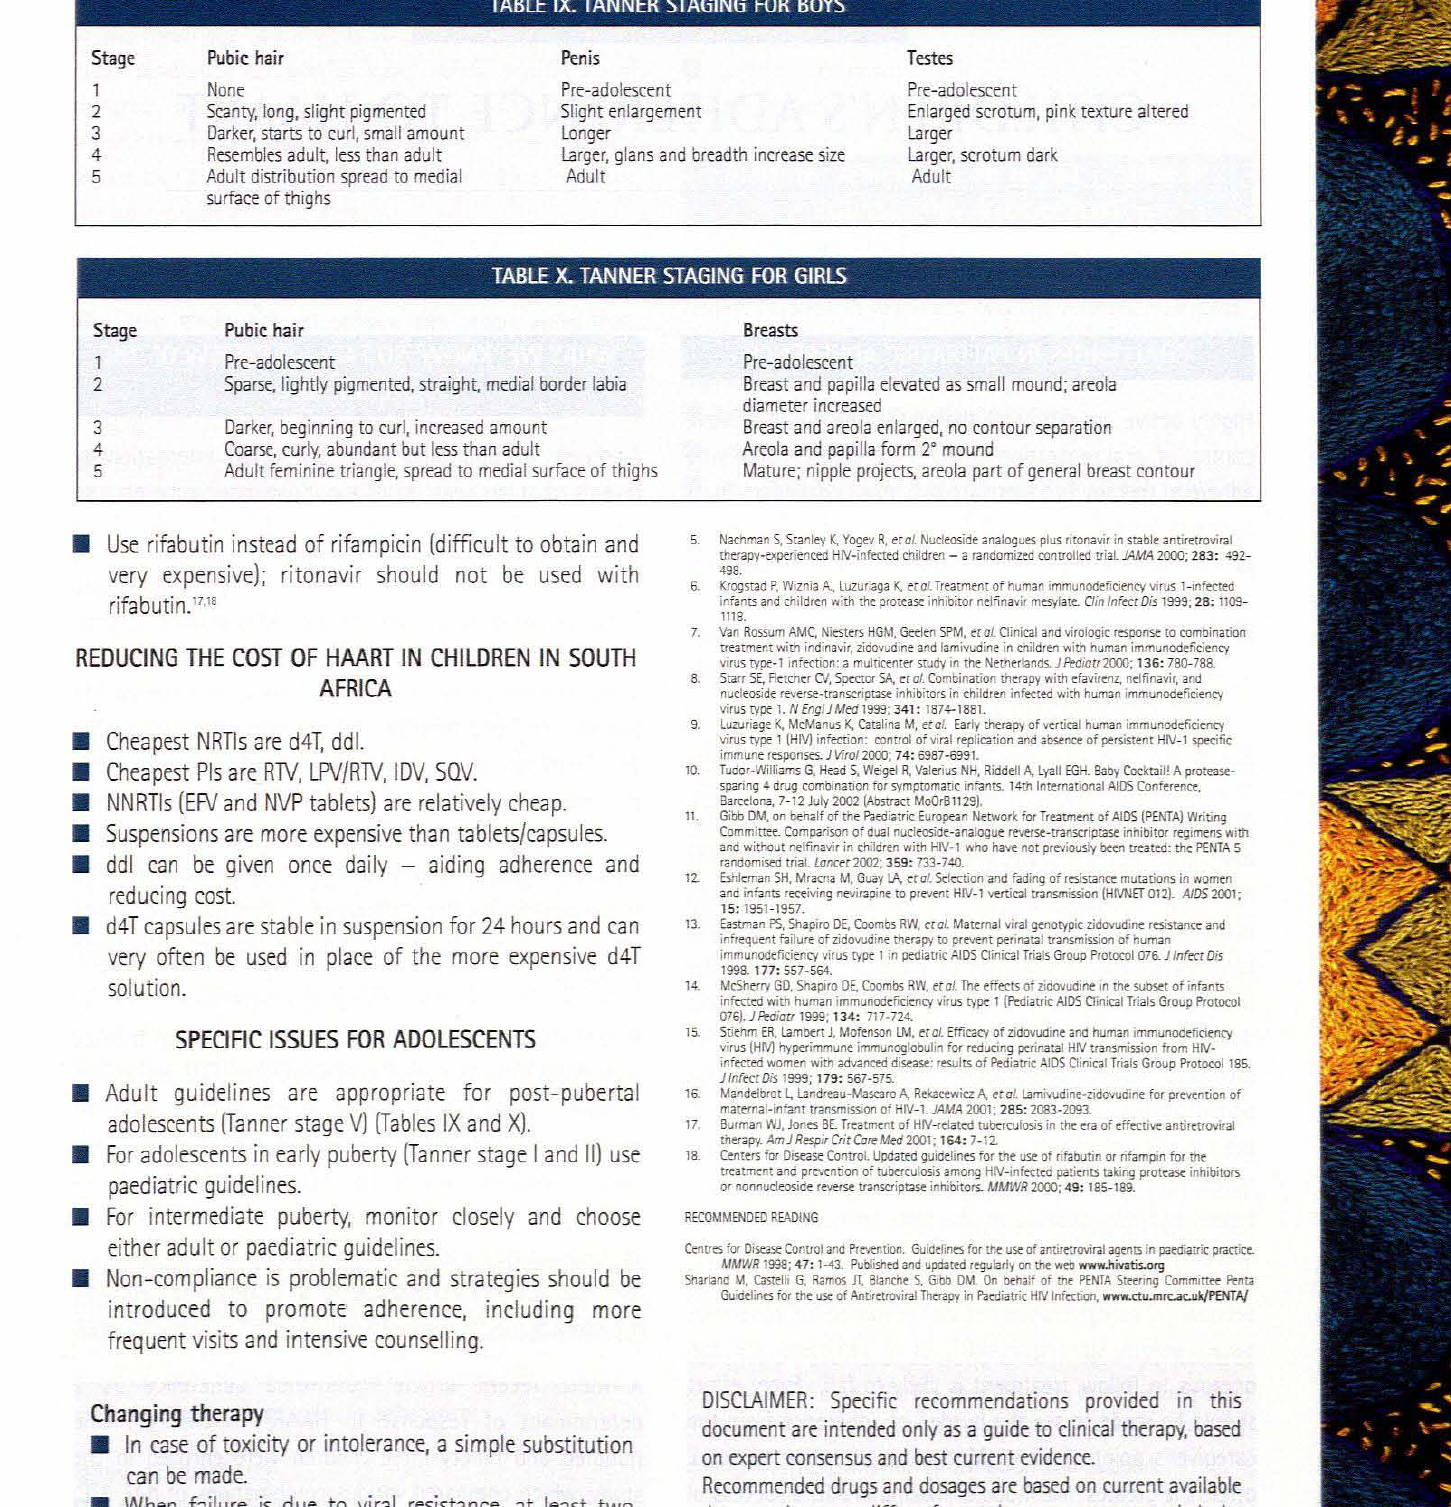
DISCLAIMER: Specific recommendations provided in this